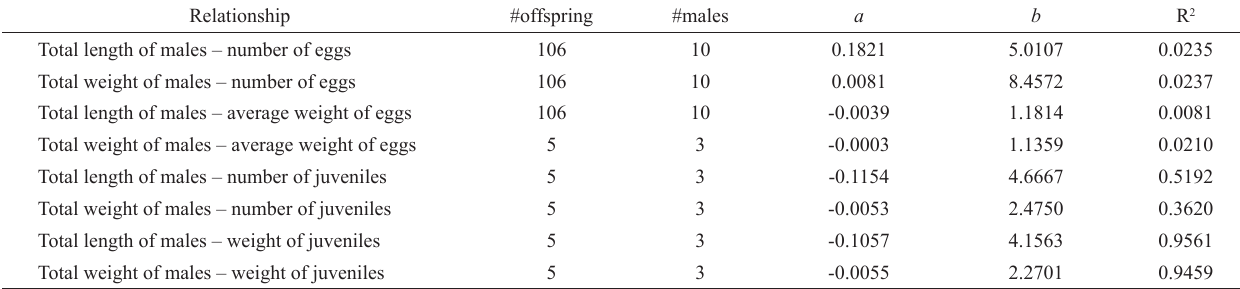
Fig. 5. Genidens genidens reproductive cycle in Guanabara Bay, Rio de Janeiro, Brazil. Fishes images are a modification of Fischer et al. (2011). Tab. 1. Linear relationship between number and weight of offspring, and length and weight of Genidens genidens males in Guanabara Bay, Rio de Janeiro,